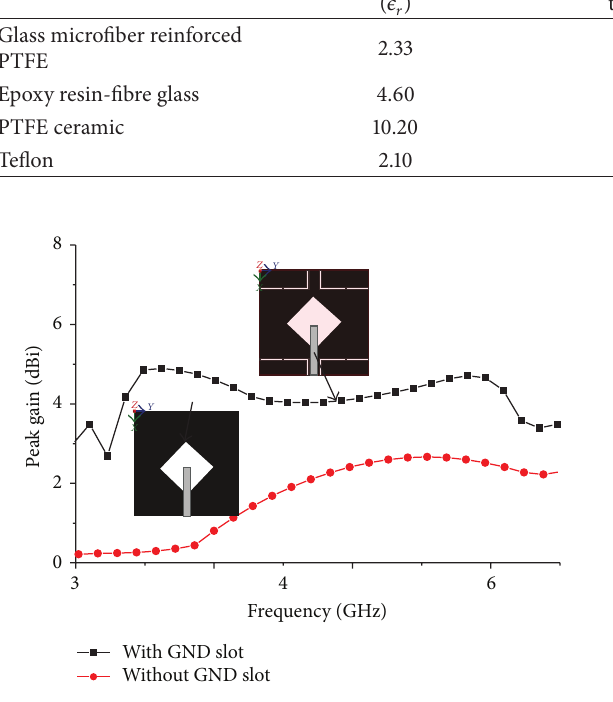
Figure 9: Effect of peak gain with and without slot in ground plane.